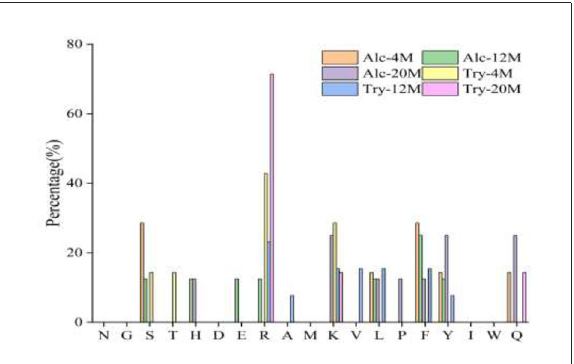
FIGURE6 Statistic result of the kind and distribution of amino acid of C-terminal in the peptides.